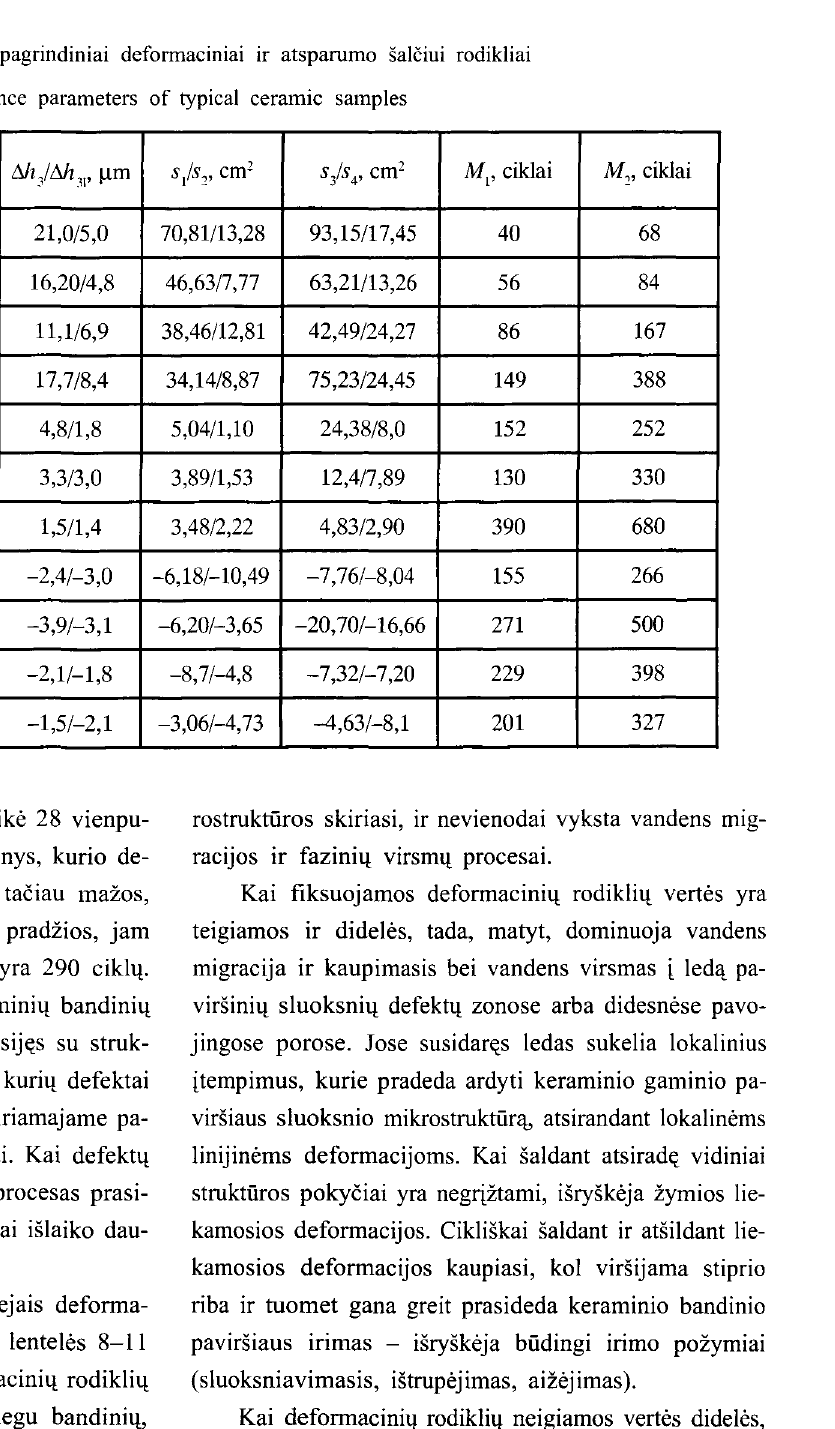
Table 1. Main deformation and frost resistance parameters of typical ceramic